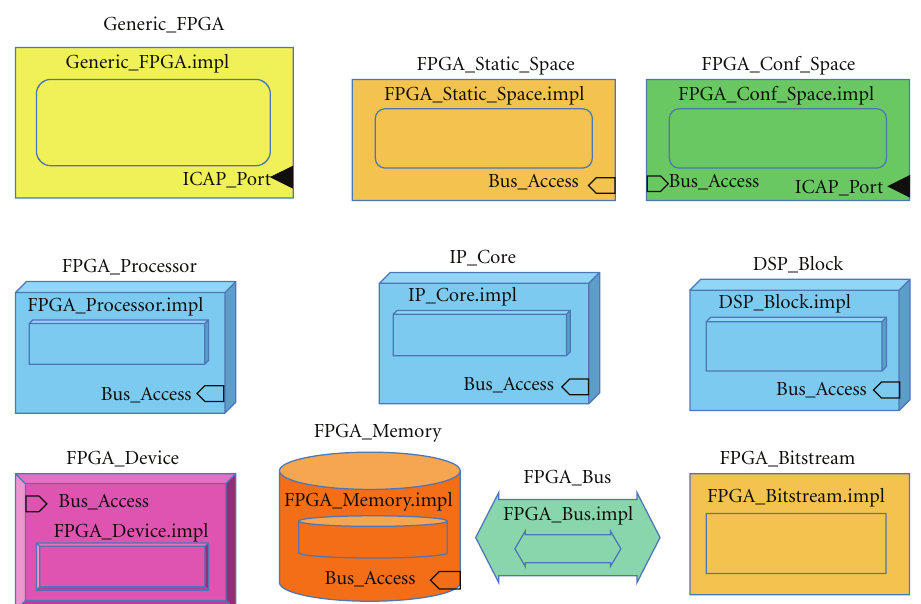
Figure 3: A diagram showing an AADL package declaring generic classifiers for FPGA components, and for all other component types that can be synthesized within the FPGA reconfigurable